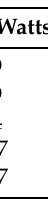
Table 12. Power states of the cortex-A7